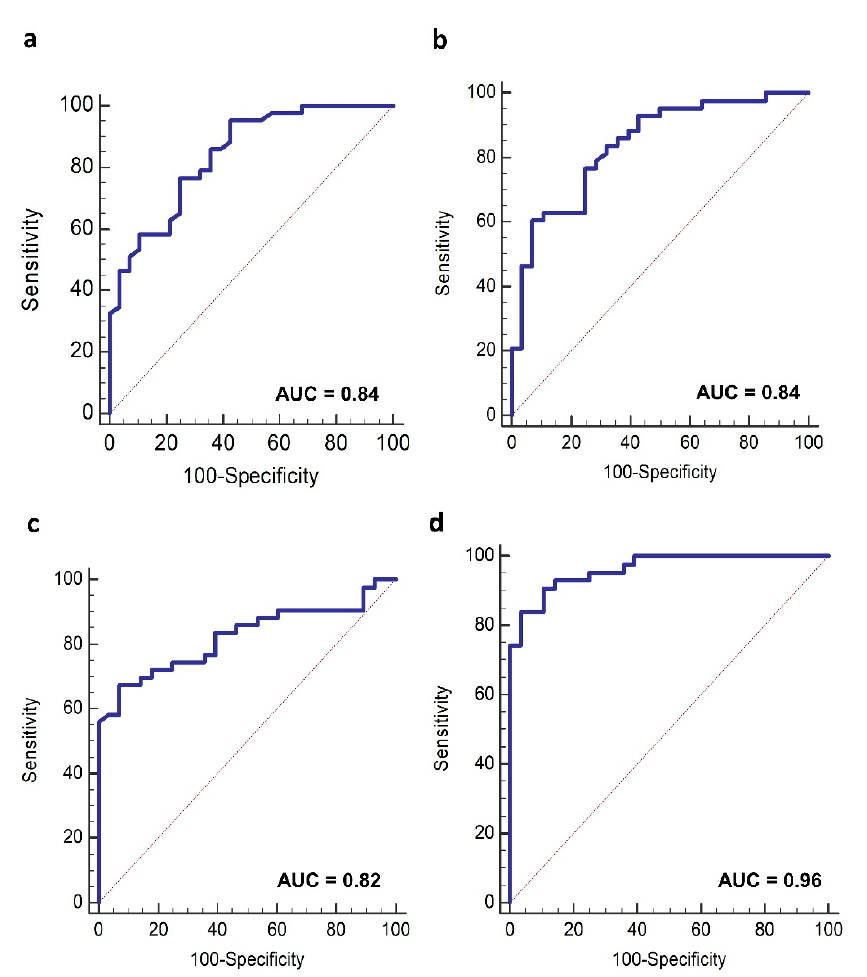
Figure 4. Receiver operating characteristic (ROC) curve analysis of the lipoproteins subfractions that best discriminate HER2-positive BC patient from CTR: free-Chol VLDL-2 ( a ); Chol-VLDL-2 ( b ); PL LDL-6 ( c ) single variables and their ROC model combination ( d ).